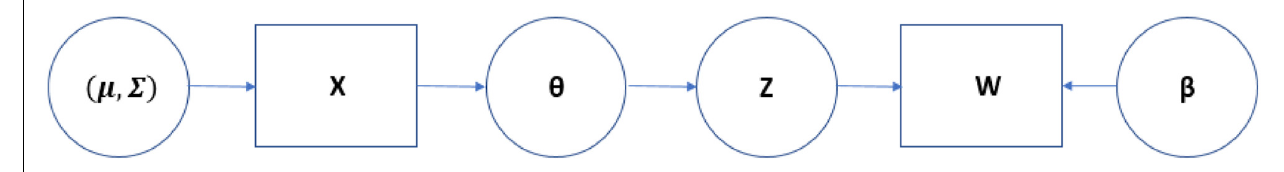
FIGURE 1 | Schematic presentation of structural topic model for this study. Note. The squares indicate the observed variables [i.e., students’ mastery status of reading skills (X) and words in the corpus of students’ writing (W)]; the circles indicate the parameters in the model.